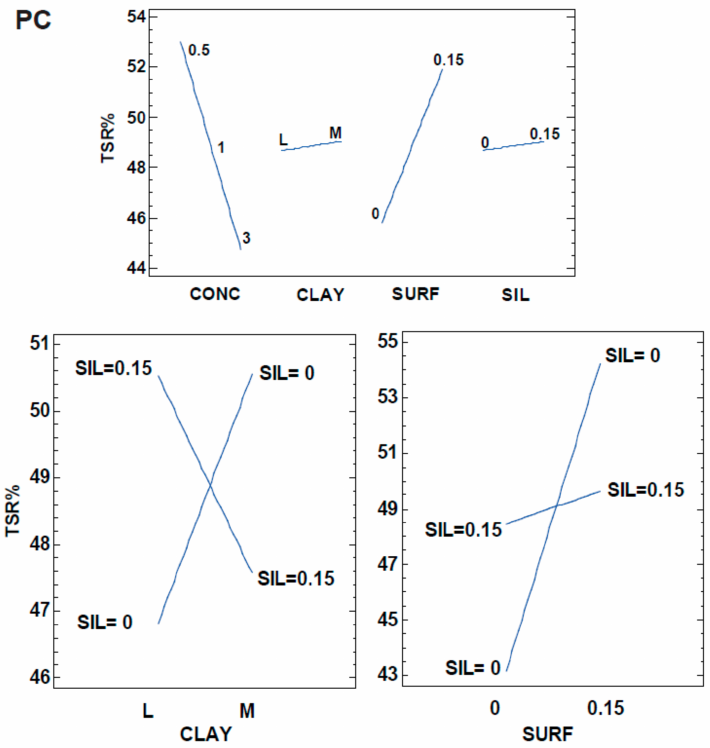
Figure 13. Main effects and interactions plots from the TSR (%) response in the PC pigments.